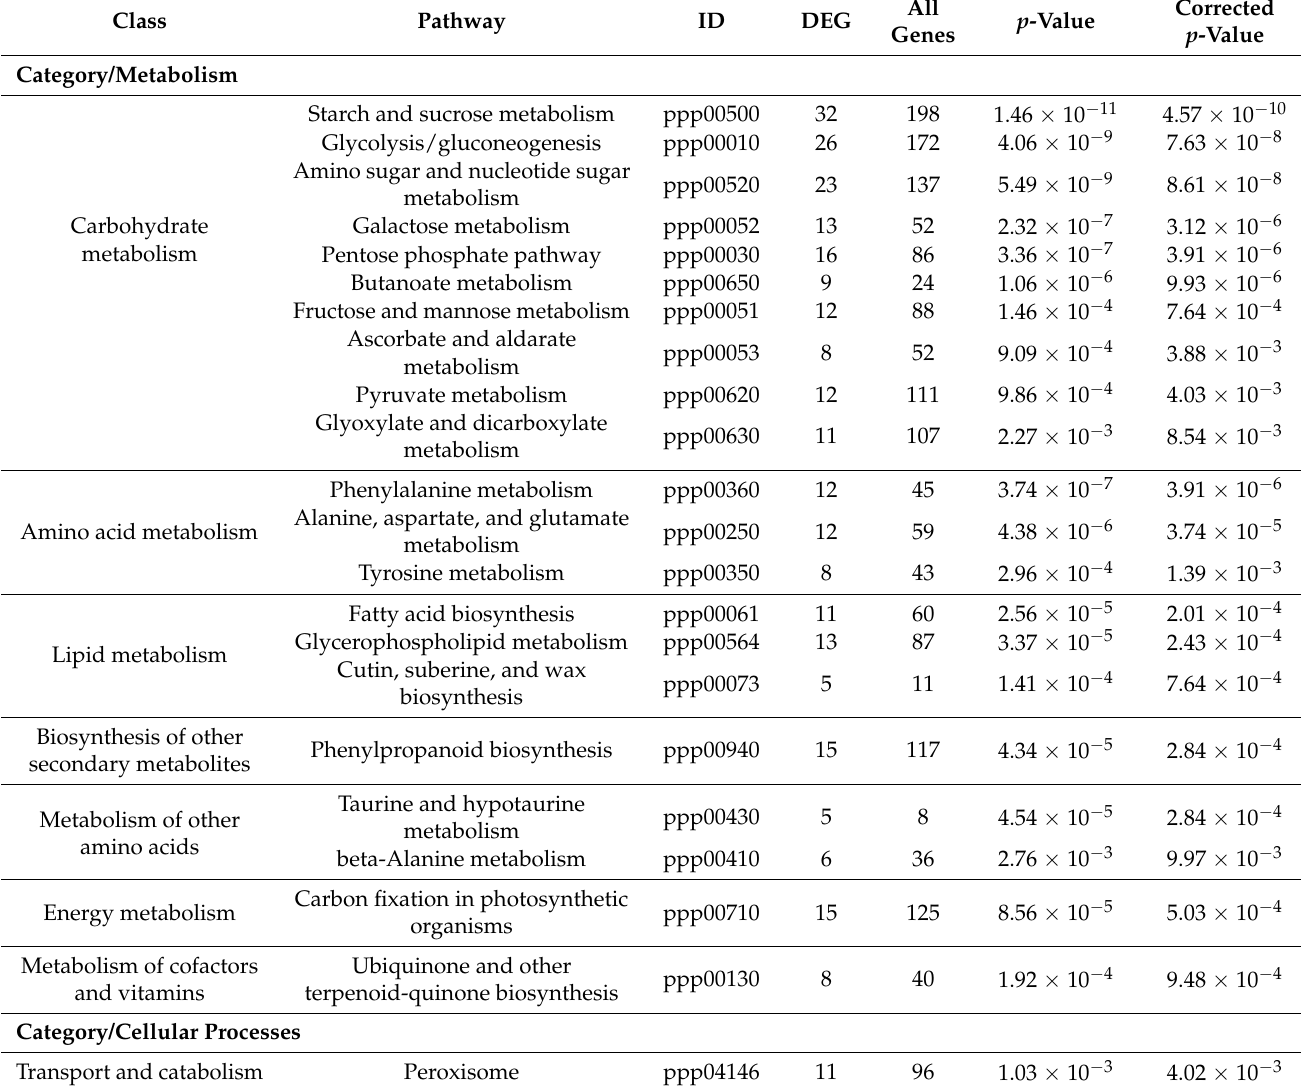
Table 3. KEGG analysis of DEGs upregulated in